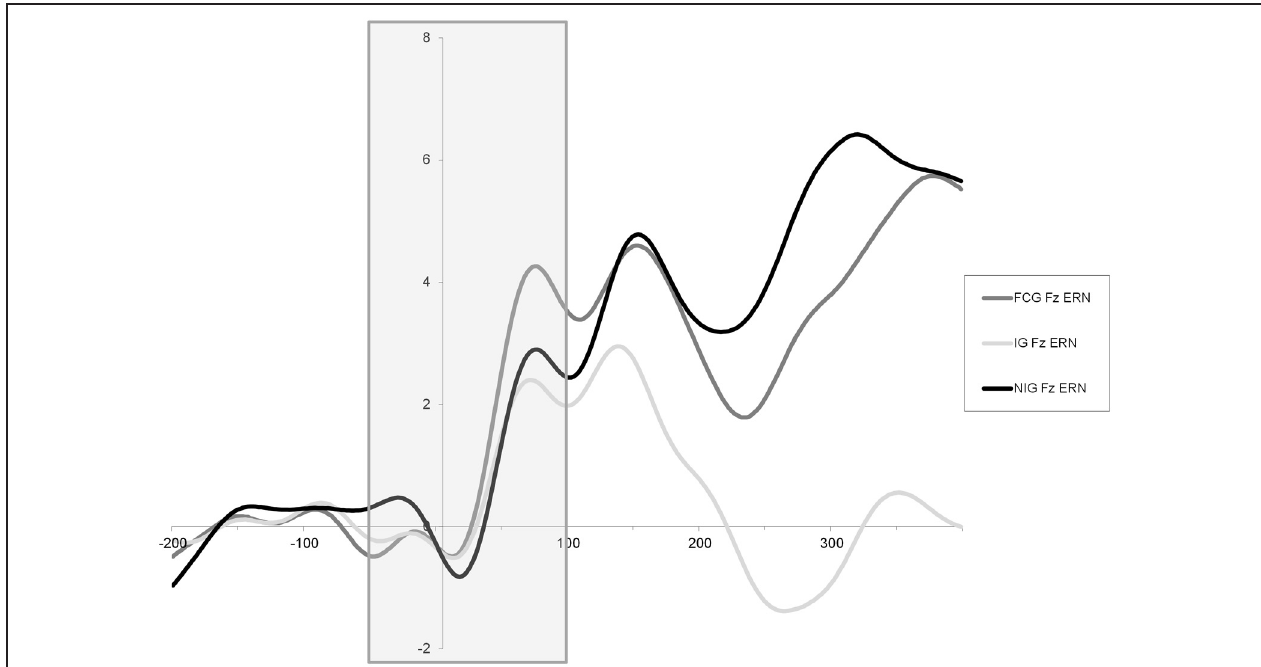
FIGURE 2 | Response-locked ERN waveform at Fz. ERN time window is outlined.